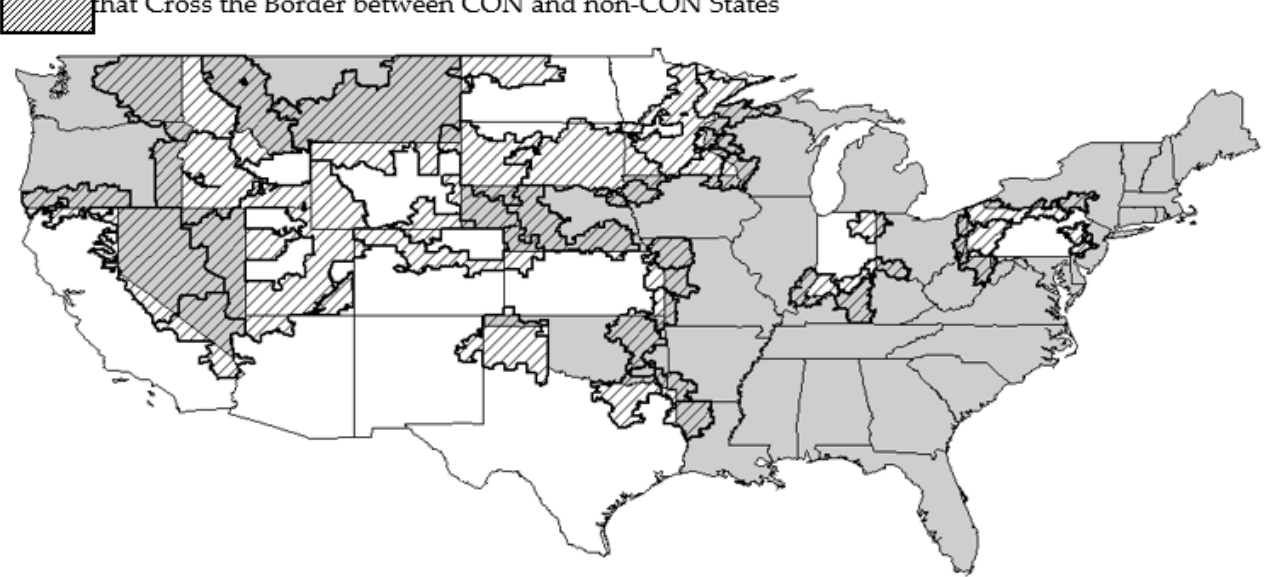
Figure 2. HRRs that crossed the borders of states with and without CON laws (2011). Note: HRRs = hospital referral regions; CON = certificate of need. Sources: NCSL (2016); Dartmouth Atlas Project (2016).